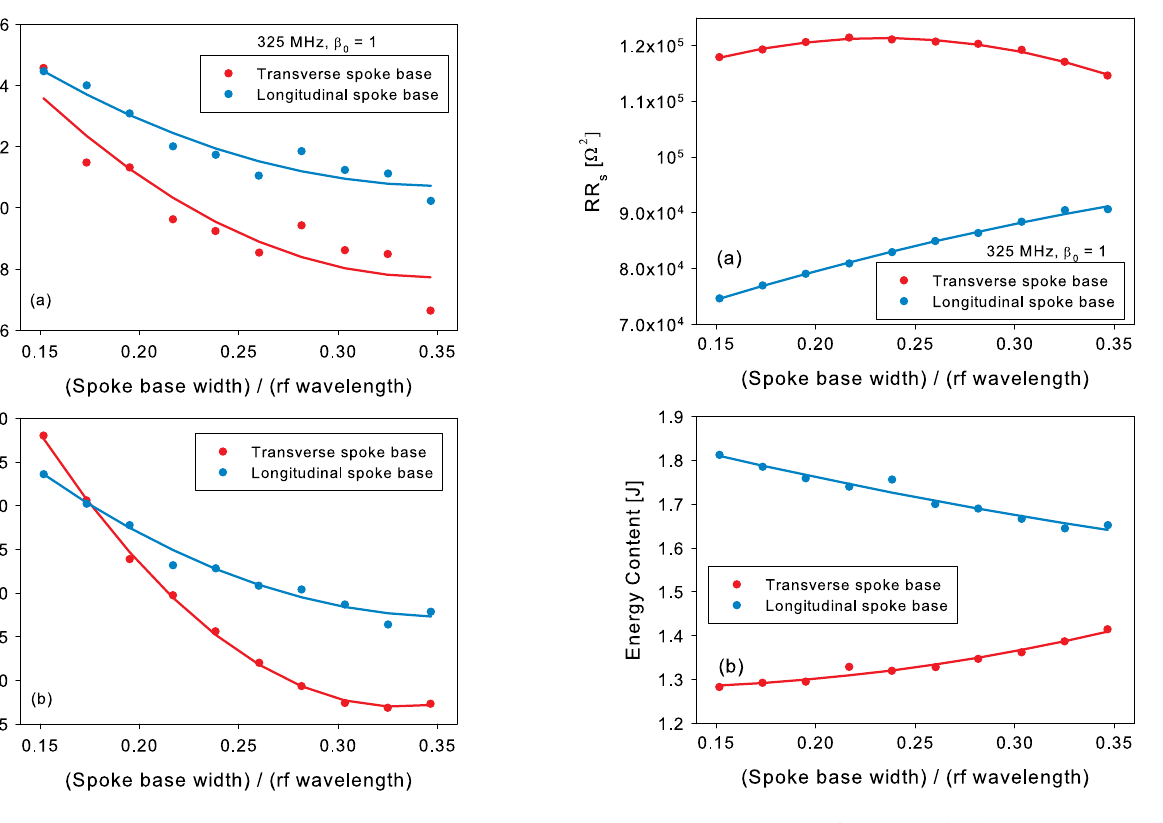
FIG. 8. (a) Dependence of E p =E acc and (b) B p =E acc on the spoke base width at a constant base length of 480